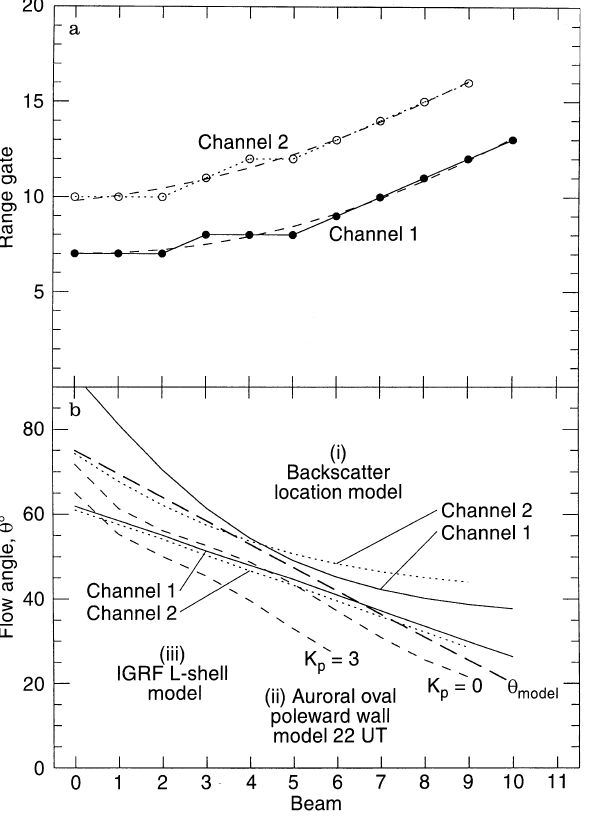
Fig. 4. a The location within the field of view of centre of the channel 1 and 2 backscatter regions ( solid and dotted lines , respectively) and least-squares fits to these curves ( dashed lines ). b The flow angle, (cid:104) , determined from the locations of the backscatter channels ( solid and dotted lines ), determined from the location of the poleward wall of the auroral oval ( dashed lines ), and determined from the geomagnetic azimuth along the channels ( dot-dashed lines ). The model variation of flow angle, (cid:104) model , assumed for the present study is also indicated ( thick dashed